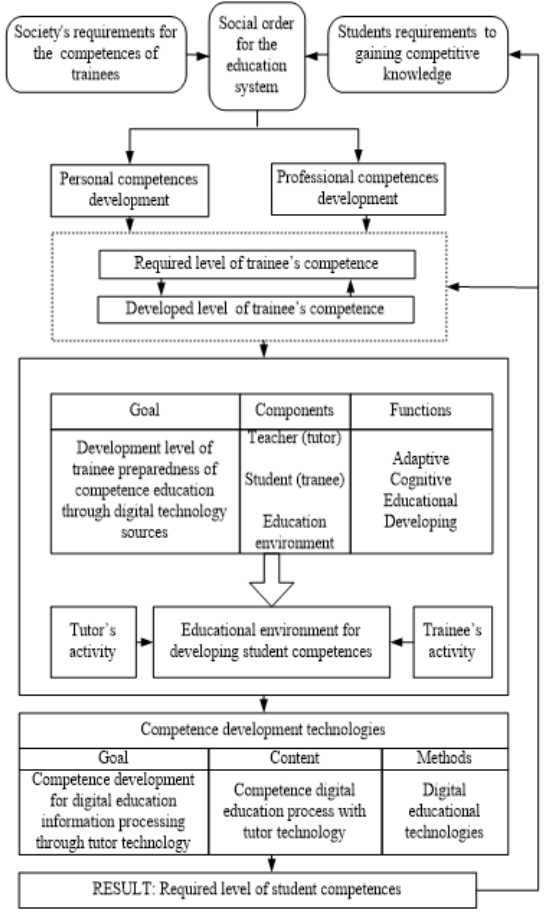
Figure 3. Competence model of